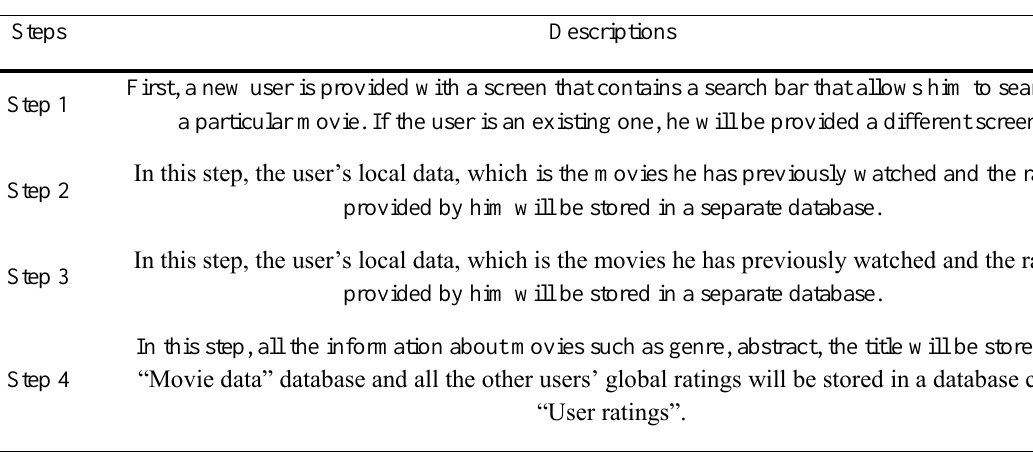
Table 4. Proposed methodology.